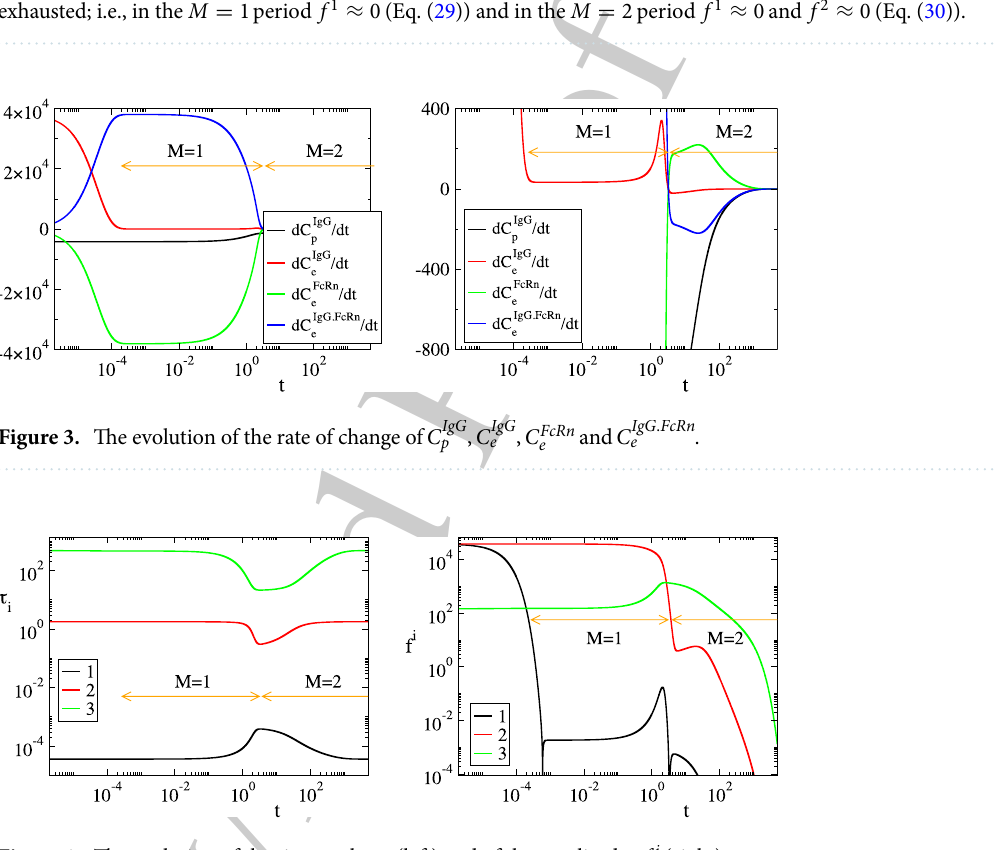
Figure 4. The evolution of the time scales τ i (left) and of the amplitudes f i (right); i = 1, 2, 3